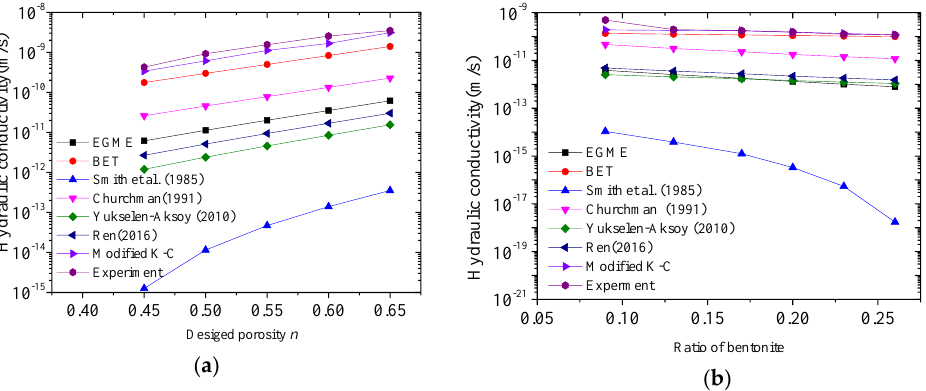
Figure 9. Hydraulic conductivities of two types of samples ( a ) S type samples; ( b ) Y type samples [7,63,74,75].